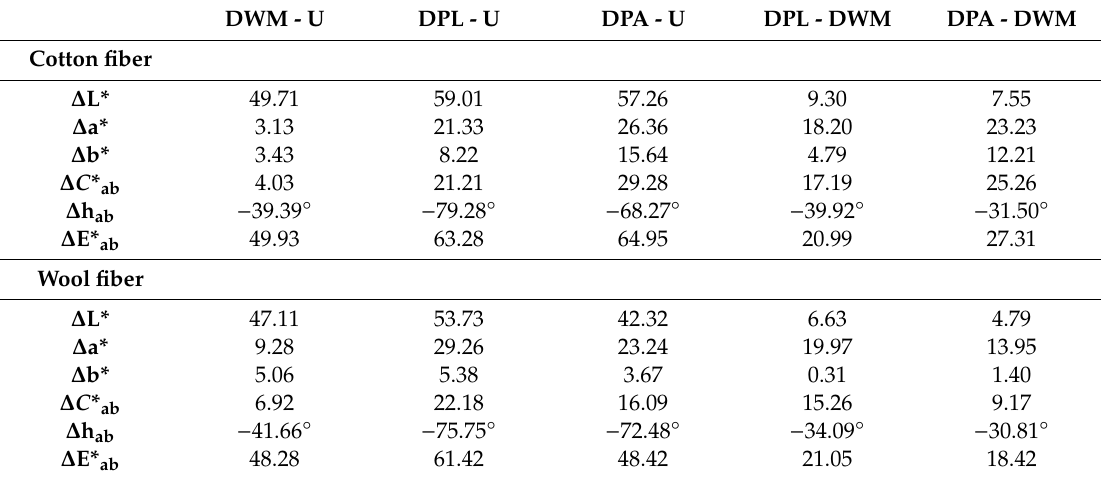
Table 3. Partial color di ff erences ( ∆ L*, ∆ a* and ∆ b*), the ‘chroma’ di ff erences ( ∆ C * ab ), the ‘hue angle’